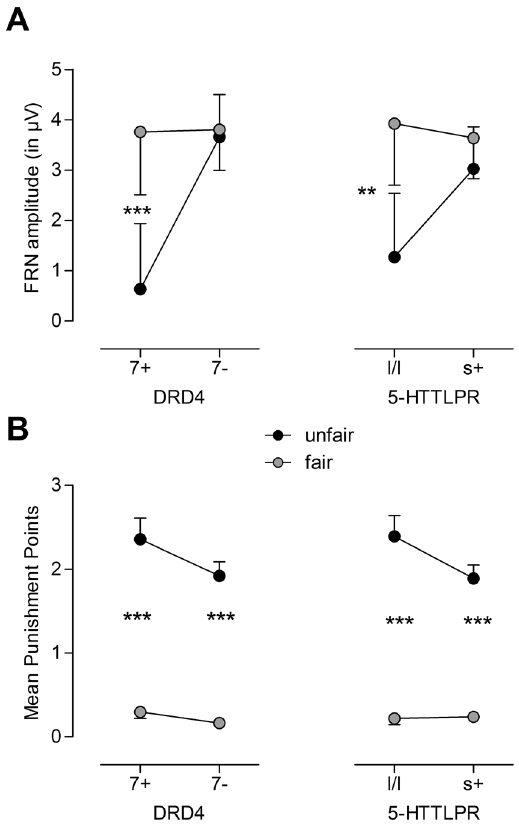
Figure 4. ( A ) Significant interactions of Fairness (unfair vs. fair) × DRD4 ( F 1,37 = 8.83, p = 0.005, partial = 4.47, p = 0.041, partial η 2 = 0.11, right panel) on FRN η 2 = 0.19, left panel) and Fairness × 5-HTTLPR ( F 1,37 amplitude in the Dictator game. ( B ) Interactions of Fairness × DRD4 ( F 1,37 = 1.36, p = 0.250, partial η 2 = 0.04, left panel) and Fairness x 5-HTTLPR ( F 1,37 = 4.31, p = 0.045, partial η 2 = 0.10, right panel) on mean punishment points in the Dictator Game; SEM of unfair (fair) trials are depicted above (below) the mean; n_DRD4_7 + = 16,